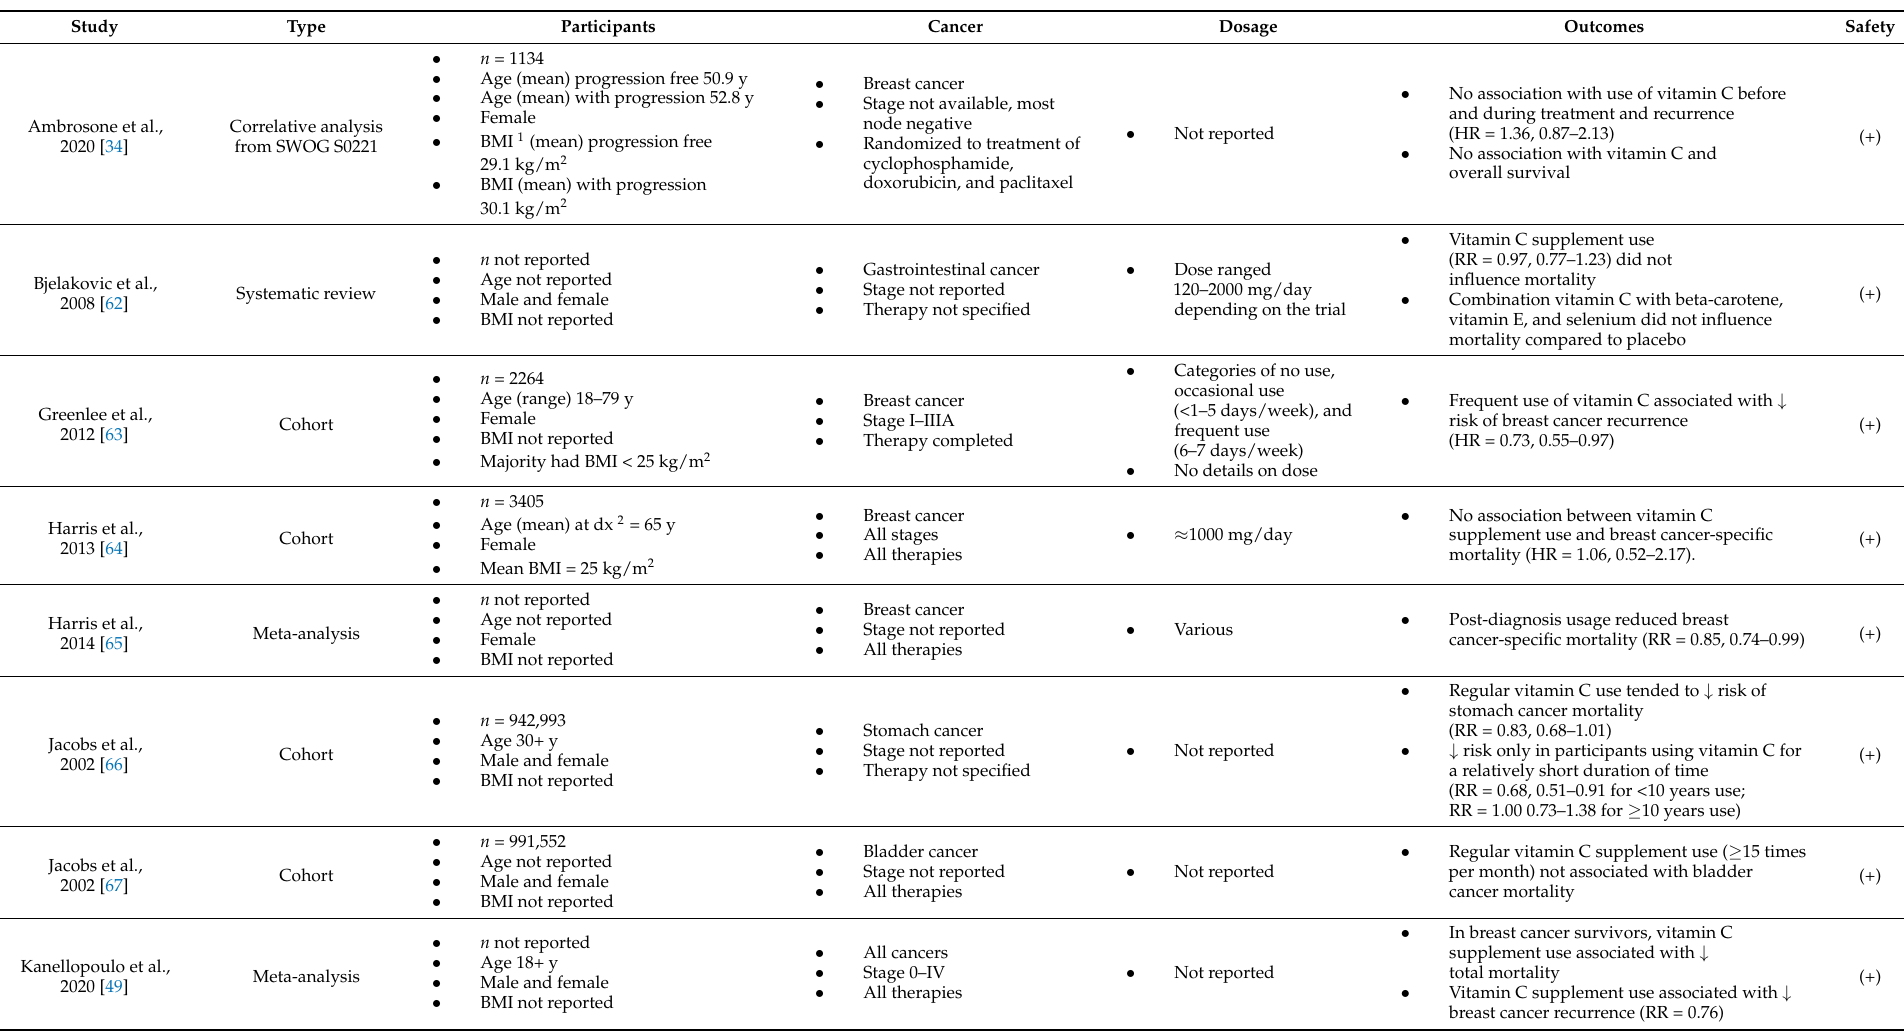
Table 2. Safety of vitamin C supplements for patients with